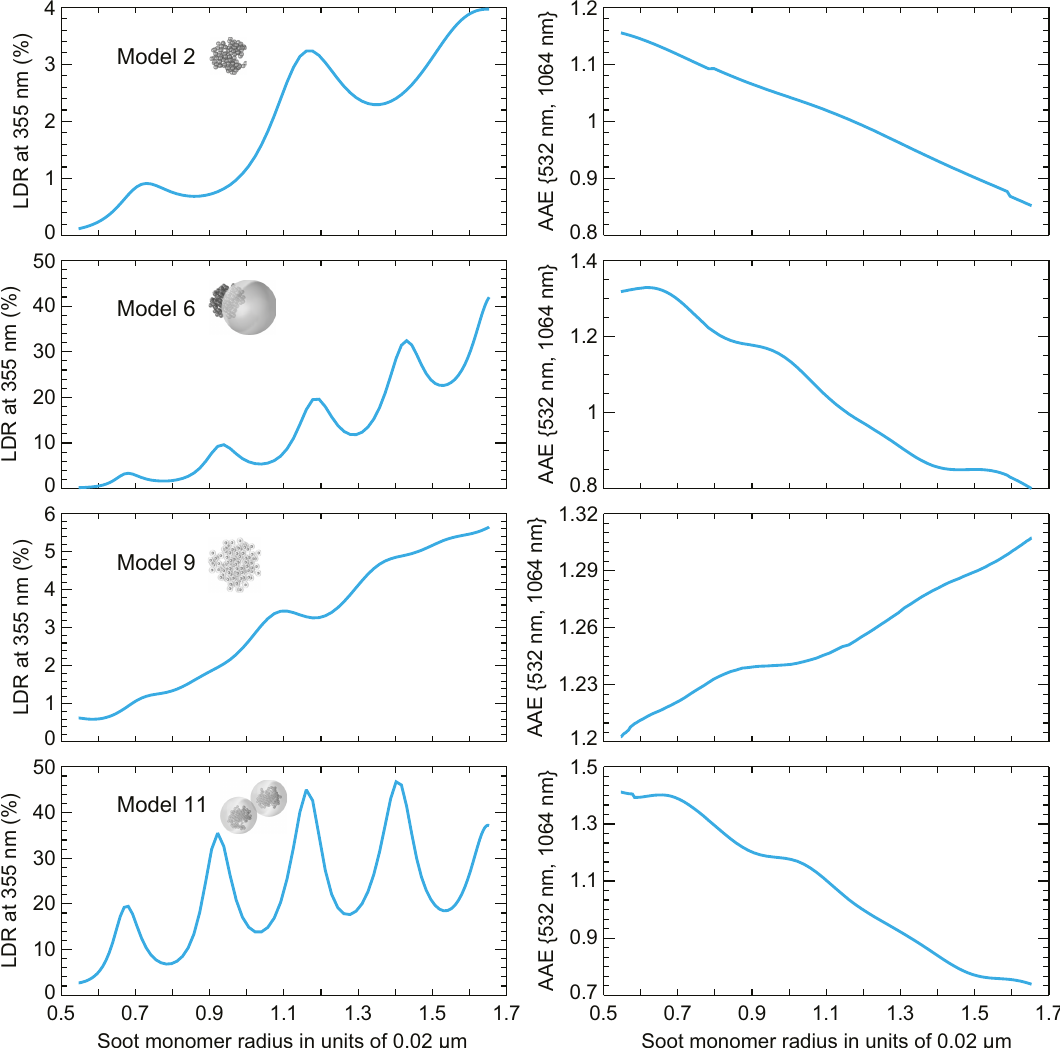
Figure 4. Linear depolarization ratio (LDR) at λ = 355 nm (left-hand panels) and absorption Ångström exponent (AAE) computed for the {532 nm, 1064 nm} pair of wavelengths (right-hand panels) as functions of soot monomer radius.